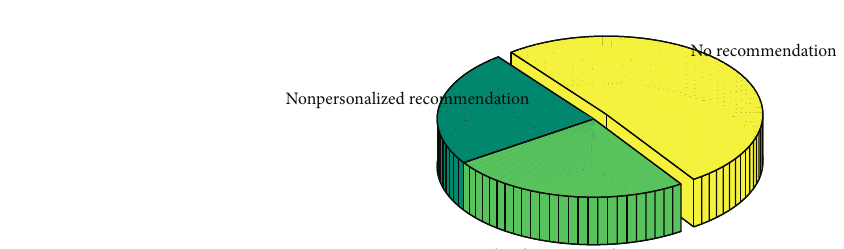
Figure 8: Performance analysis of L-Apriori algorithm.